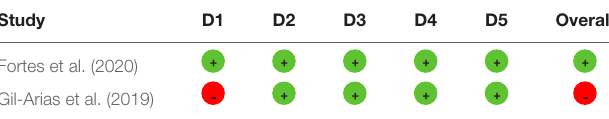
TABLE 4 | Assessment of RoB.